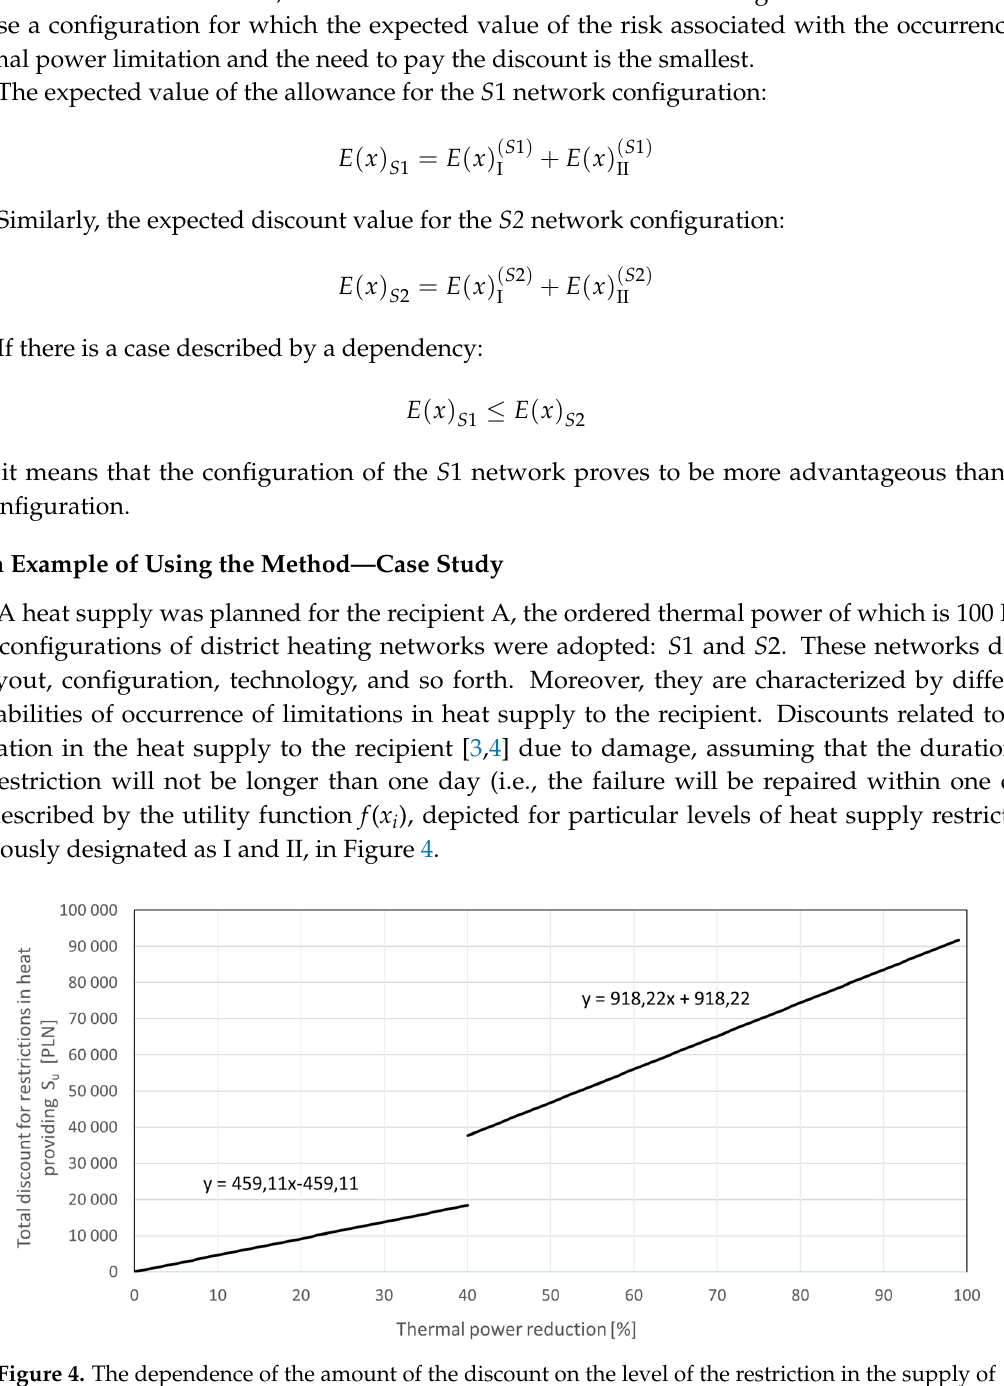
Figure 4. The dependence of the amount of the discount on the level of the restriction in the supply of thermal power to the recipients.